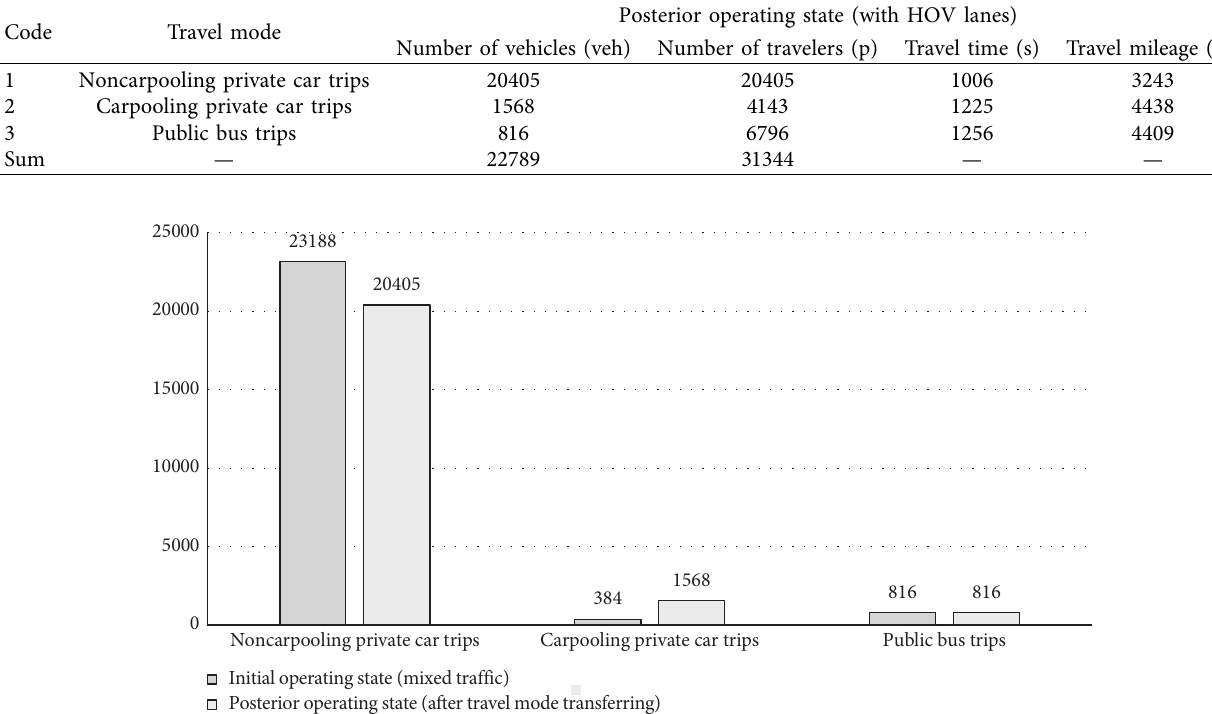
Figure 7: Comparison of number of trips before and after implementing HOV lanes priority dynamic control for different travel